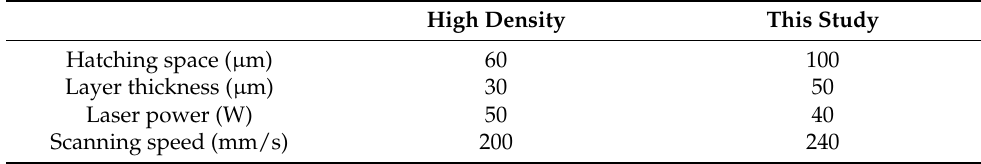
Table 2. Process parameters of 3D